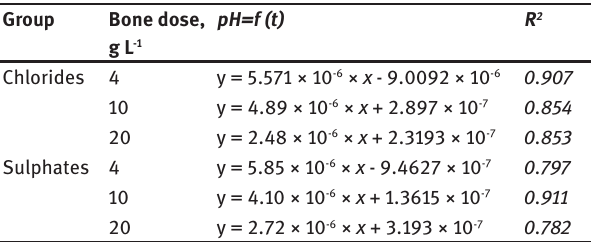
Figure 1: The relationship between pH and P a solubilization process performed by Bacillus megaterium . Table 1: The equation describing the change in the pH during the solubilization process/growth of B. megaterium .